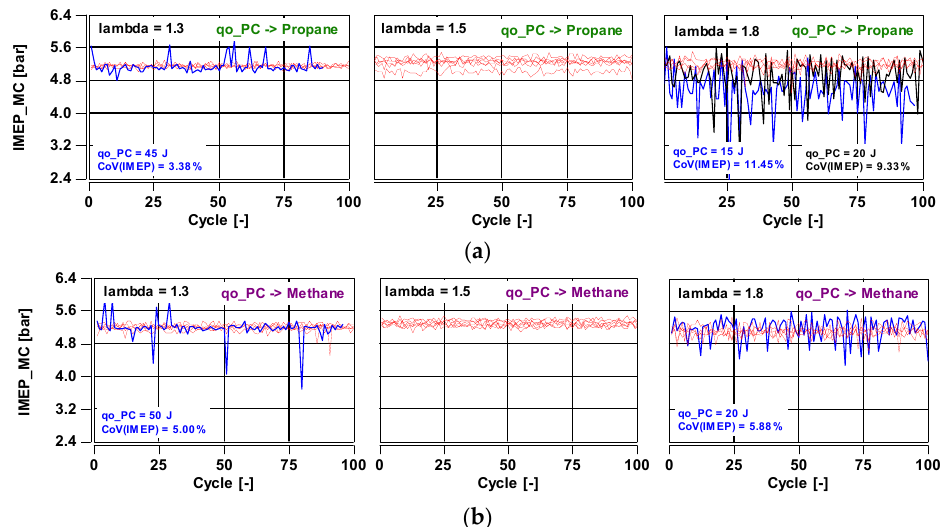
Figure 7. Instability of engine operation determined by IMEP for each value of excess air ratio: ( a ) when burning propane in the prechamber; ( b ) when burning methane in both chambers (values of the largest IMEP changes are marked in the figure).